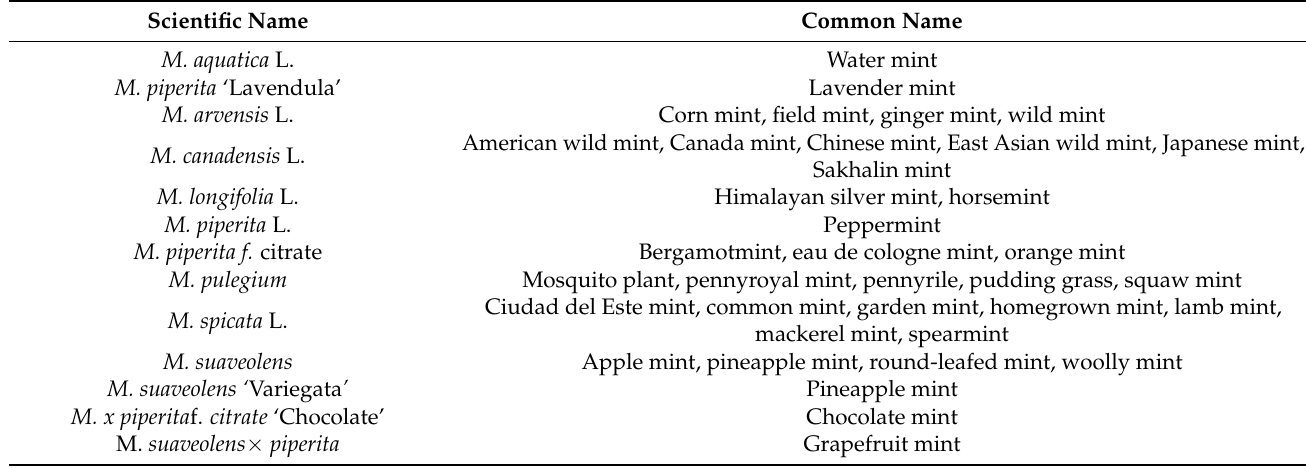
Table 1. Scientific names and common names of Mentha